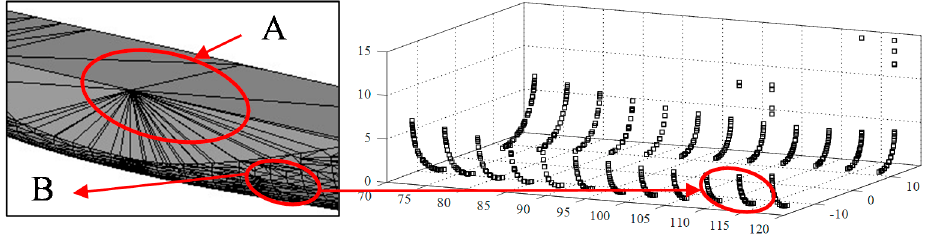
Figure 4. Non-uniform distribution of points (Left: midship area of KCS model; Right: sliced data).